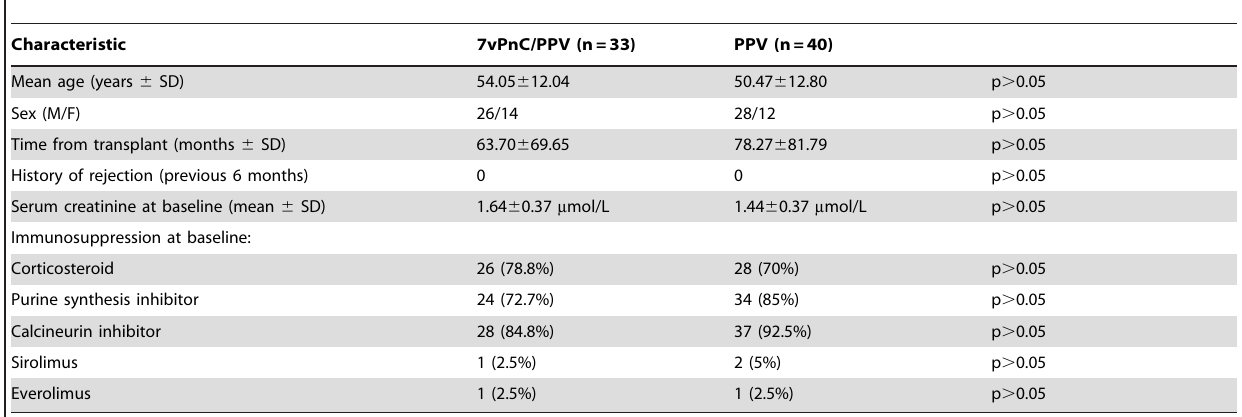
Table 1. Baseline characteristics of renal transplant recipients stratified for primary endpoints.